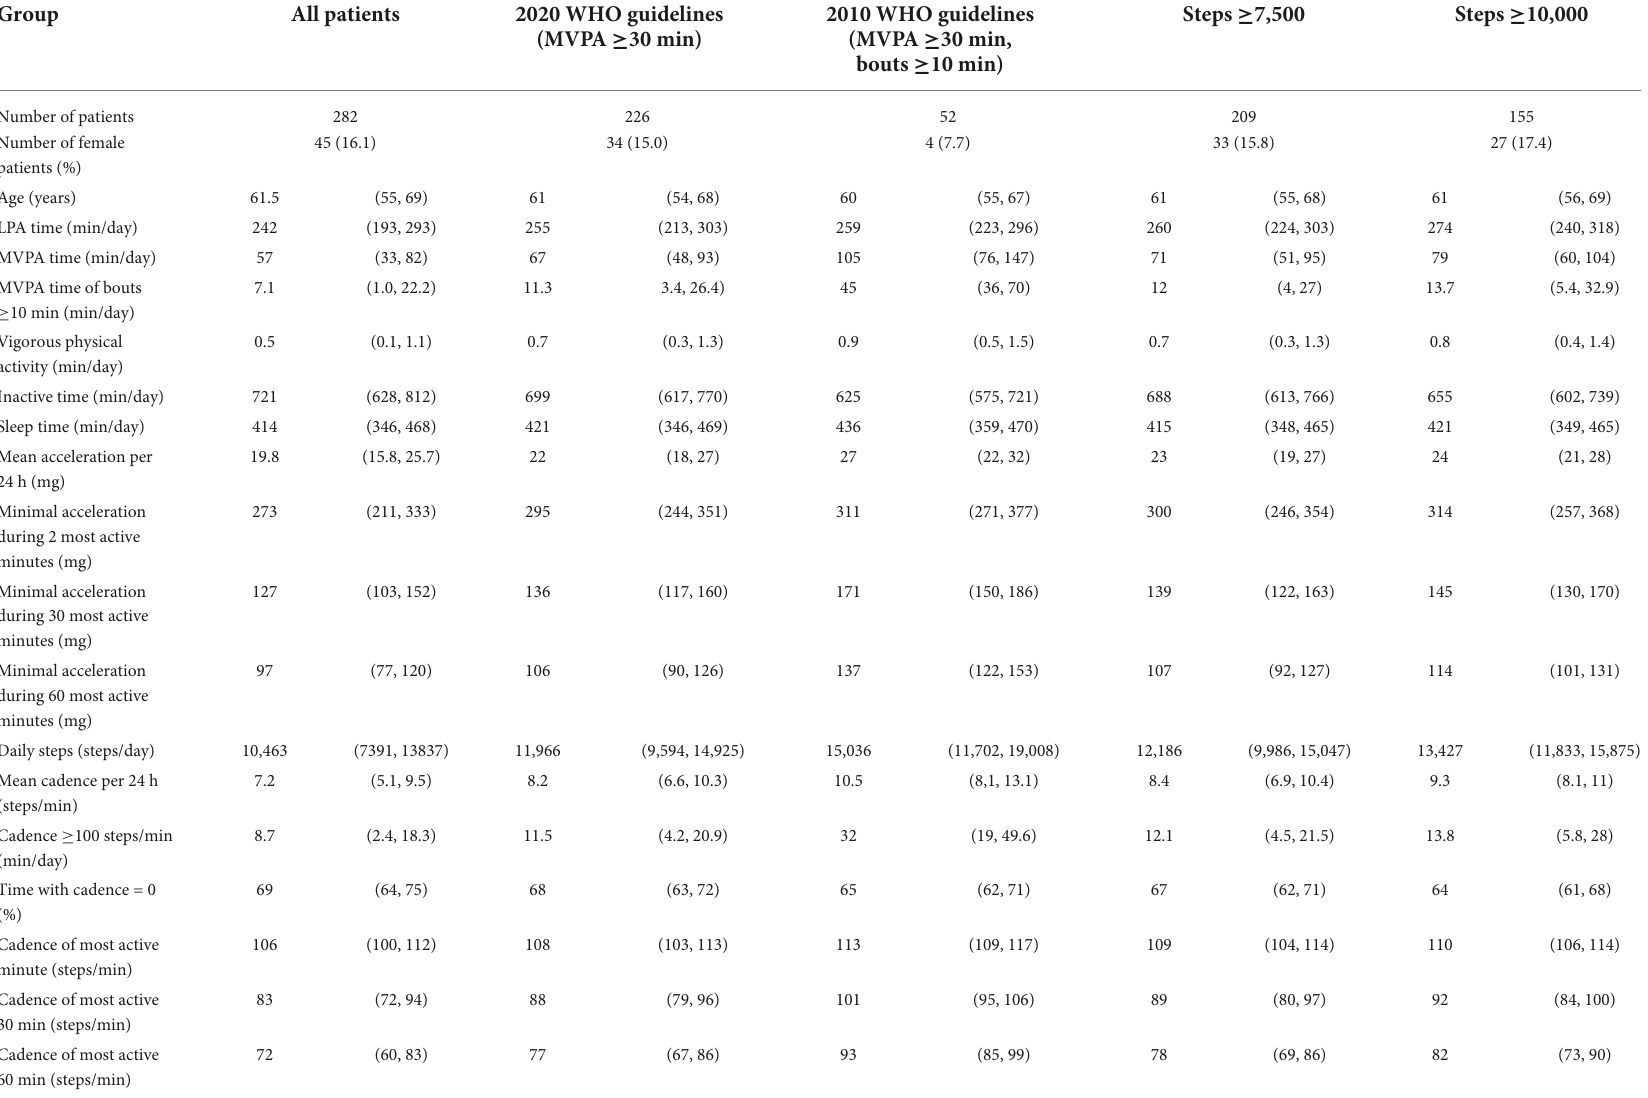
Parameters are indicated as group medians and first and third quartiles (in brackets) based on patients’ means over the measuring period. Inactive time: minutes with accelerations < 25 mg; MVPA (moderate to vigorous physical activity): minutes with acceleration ≥